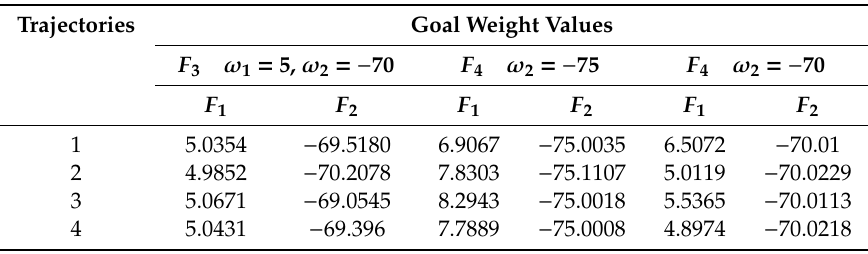
Table 3. Influence of goal value selection on the optimization